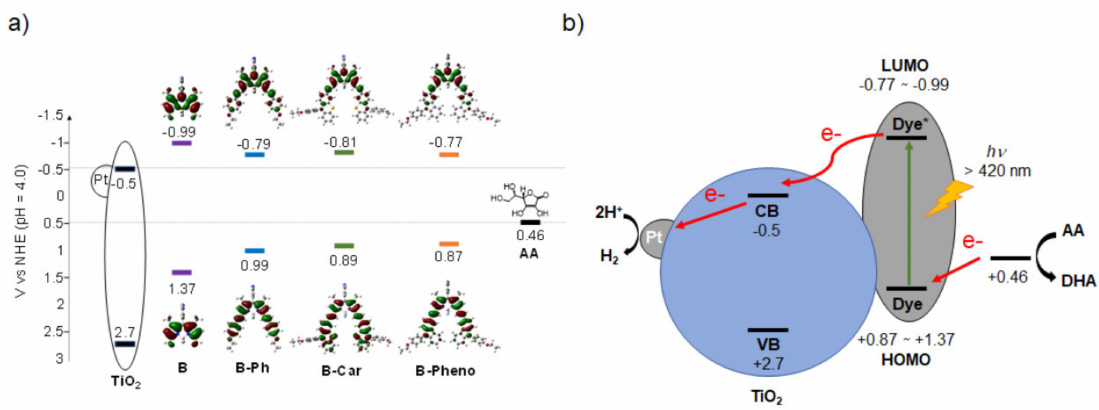
Figure 10. ( a ) Energy diagram of dyes ( B, B-Ph , B-Car , and B-Pheno ), 0.75wt% Pt-TiO 2 , and ascorbic acid. ( b ) Proposed mechanism of the photocatalytic